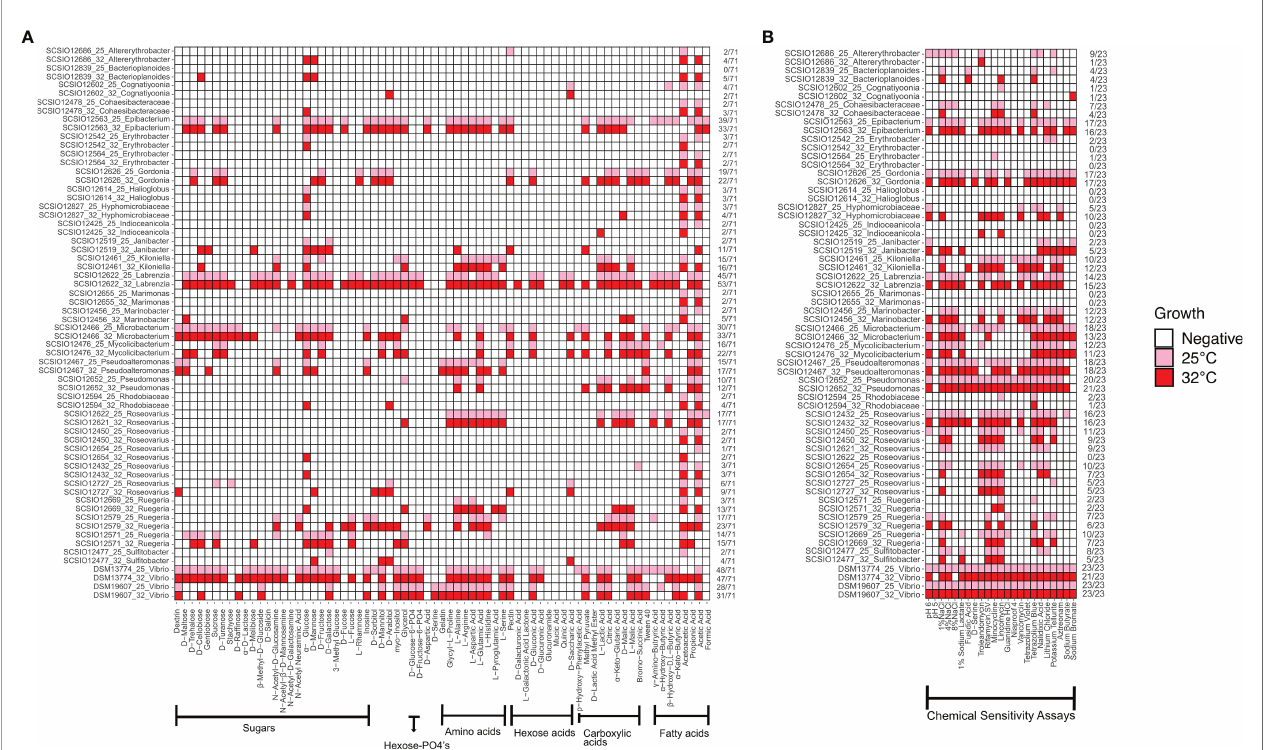
FIGURE 1 | Phenotypic fi ngerprints of the coral-associated isolates at 25°C and 32°C. The pink (red) square of the heat map indicates that the phenotypic test is positive at 25°C (32°C). The white square of the heat map indicates that the phenotypic test is negative at 25°C and 32°C. Seventy-one carbon sources (A) plus 23 chemical sensitivity assays (B) were listed on the top of the heatmap. Isolates listed on the left side were ordered by taxa name. The categories of physiological and biochemical characteristics are shown at the bottom. The number of positive tests and the sum for each row were presented on the right side of the